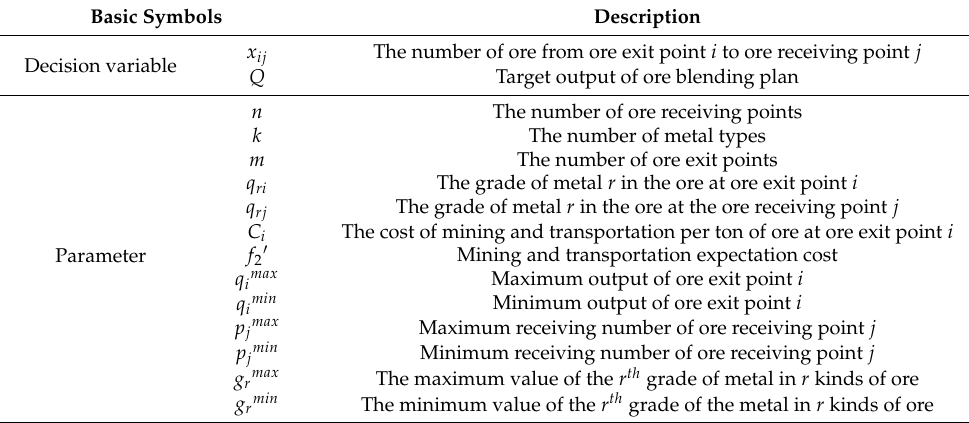
Table A1. Description of basic